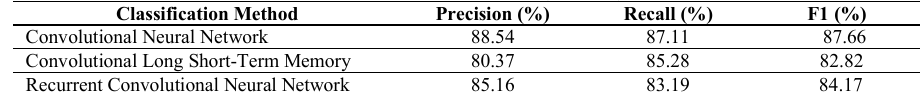
TABLE 8 C OMPARISON OF AVERAGE PRECISION , RECALL , AND F